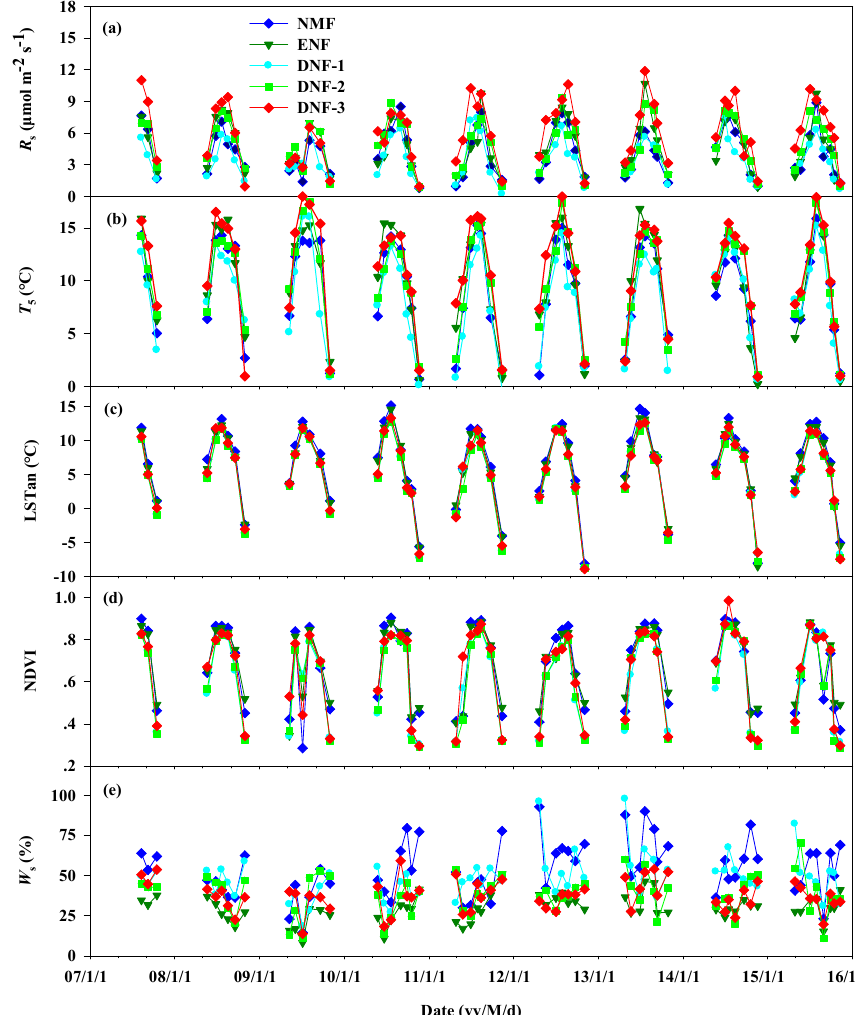
Figure 1. Seasonal variations in the ( a ) soil respiration rate ( R s , μmol CO 2 m −2 s −1 ), ( b ) soil temperature at 5 cm depth ( T 5 , °C), ( c ) land surface nighttime temperature from MODIS-Aqua (LST an , °C), ( d ) normalized difference vegetation index (NDVI), and ( e ) soil water content at 0 to 10 cm (W s , %) at the five sites during measurement.